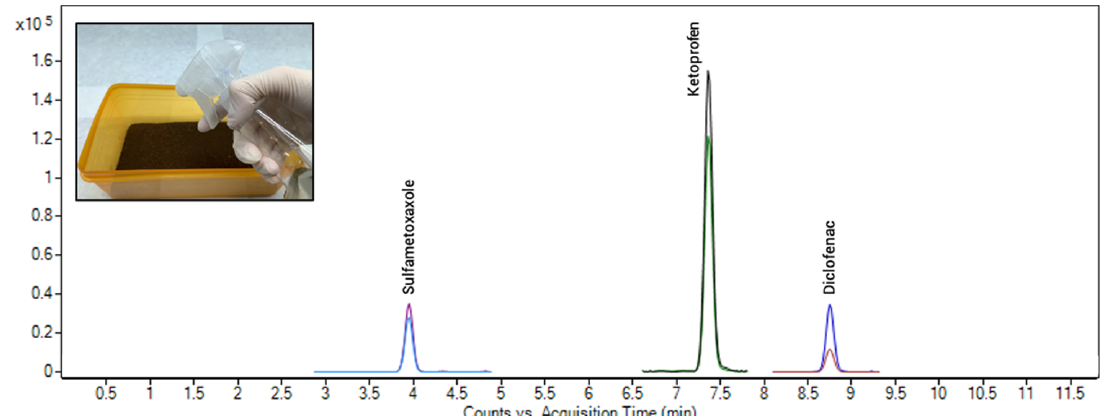
Figure 4. Chromatogram of the soil after the irrigation simulation experiment.